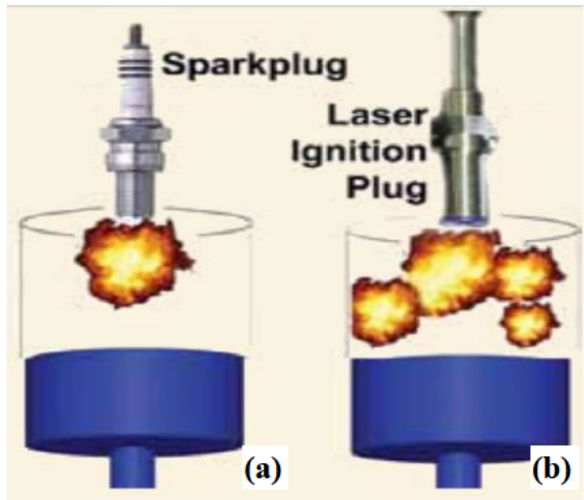
Figure 12: The spark plug ignites the fuel at the top (a), whereas the laser ignition plug simultaneously lights the fuel in multiple locations